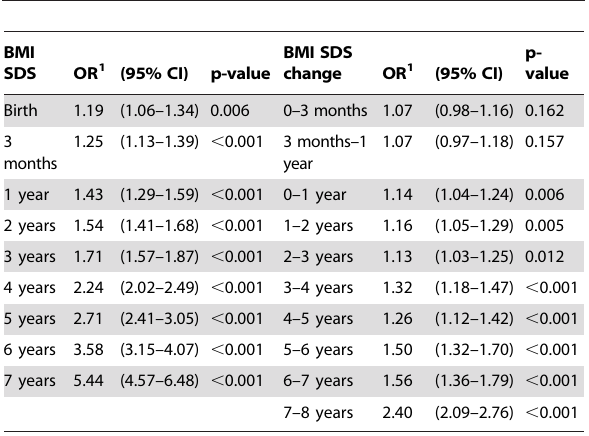
Table 4. Associations between BMI SDS and BMI SDS change from birth to 8 years of age and overweight at 8 years of age.